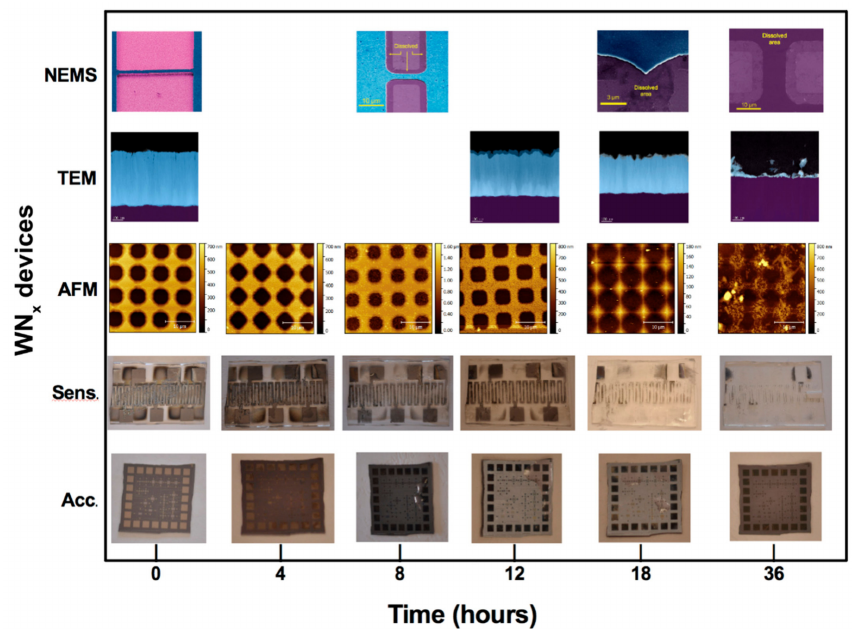
Figure 3. Extensive physical images showing complete dissolution of WN x devices over time. Devices are submerged in ground water at room temperature, with no